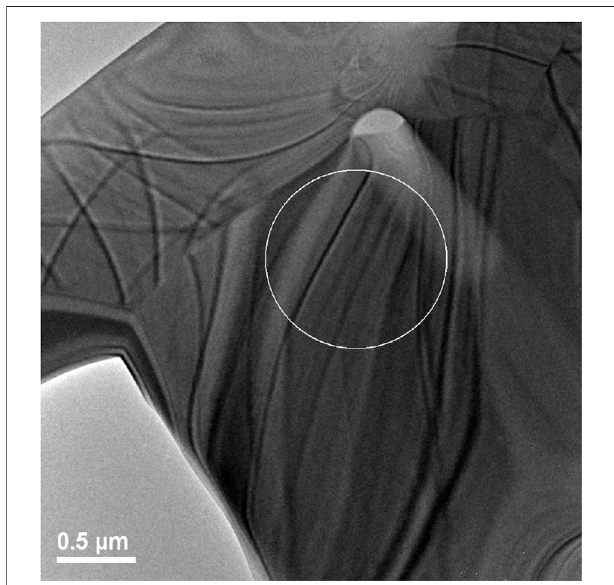
FIGURE 7 | Image showing region where high resolution TEM was performedonirradiatedEr 2 Ti 2 O 7 sample.Grainboundariescaneasilybeseen in the image as well as bend